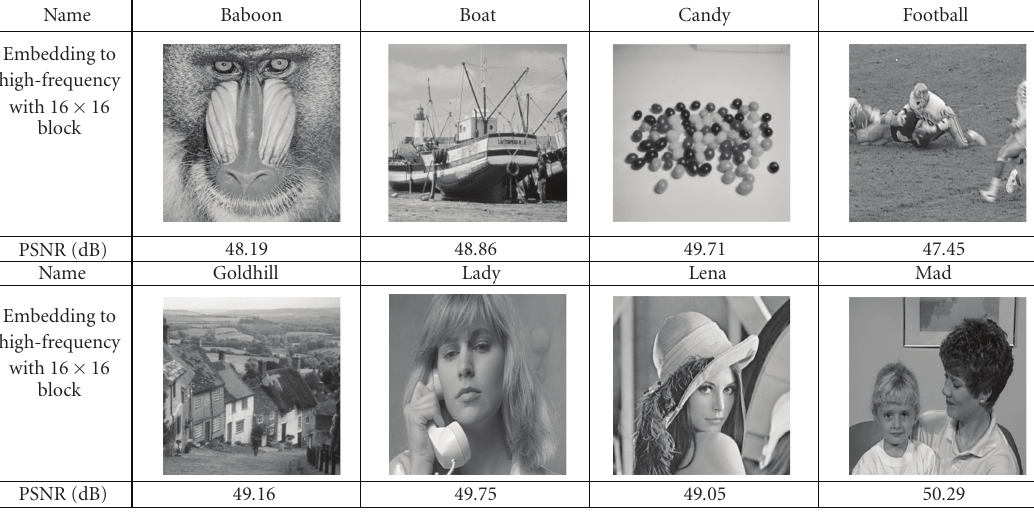
Figure 9: The result of ROI image embedded into an original image